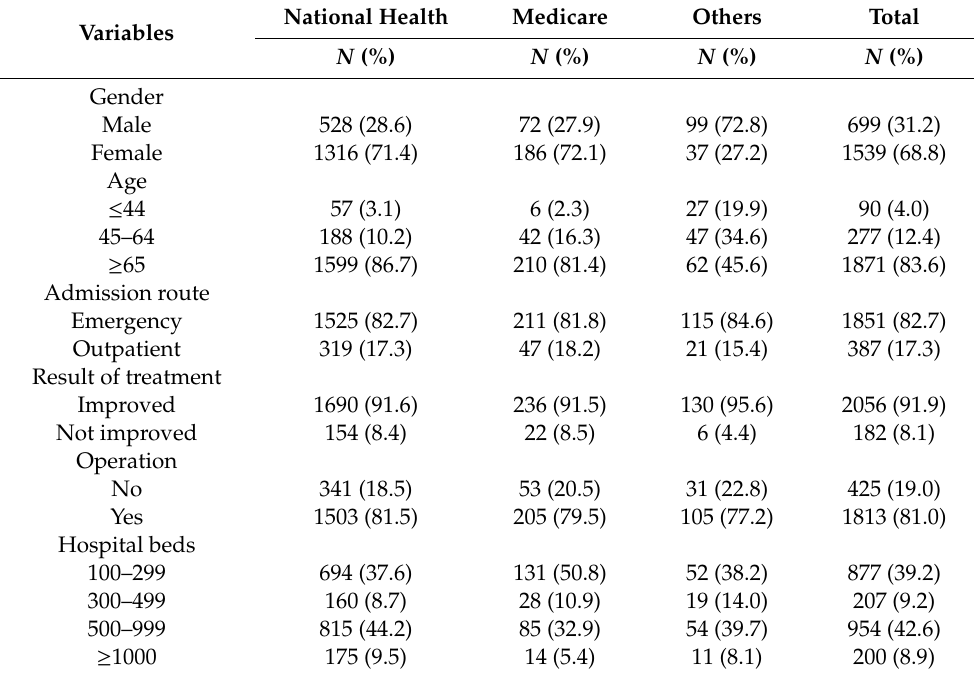
Table 1. Description of the study population according to the insurance type.